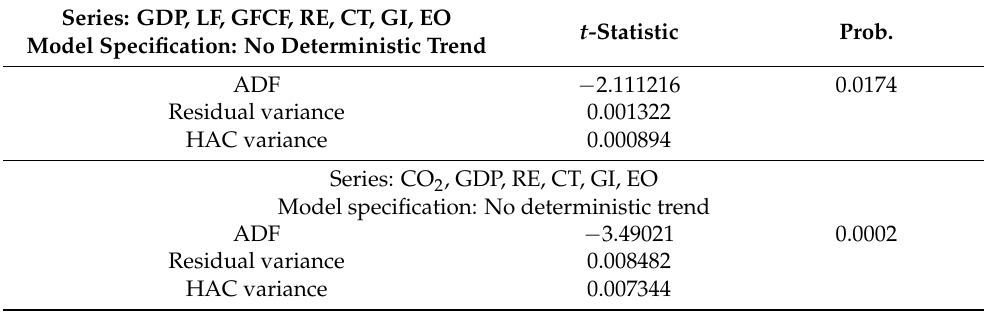
Table 5. Kao Residual Cointegration